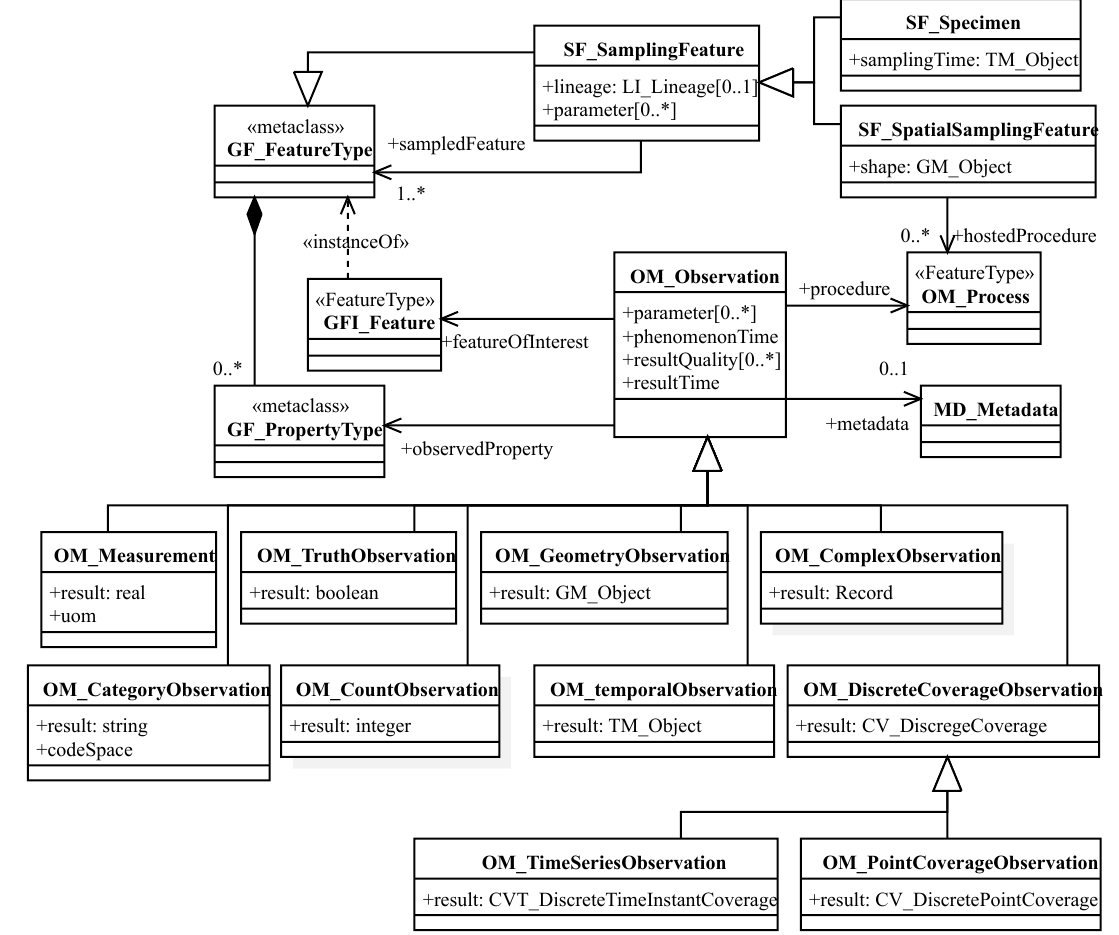
Figure 6. Main structures of the OGC observations and measurements (O&M) data